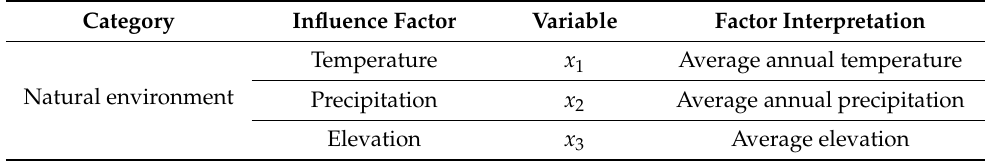
Table 4. Driving factors of the coupling coordination degree between RLUT and